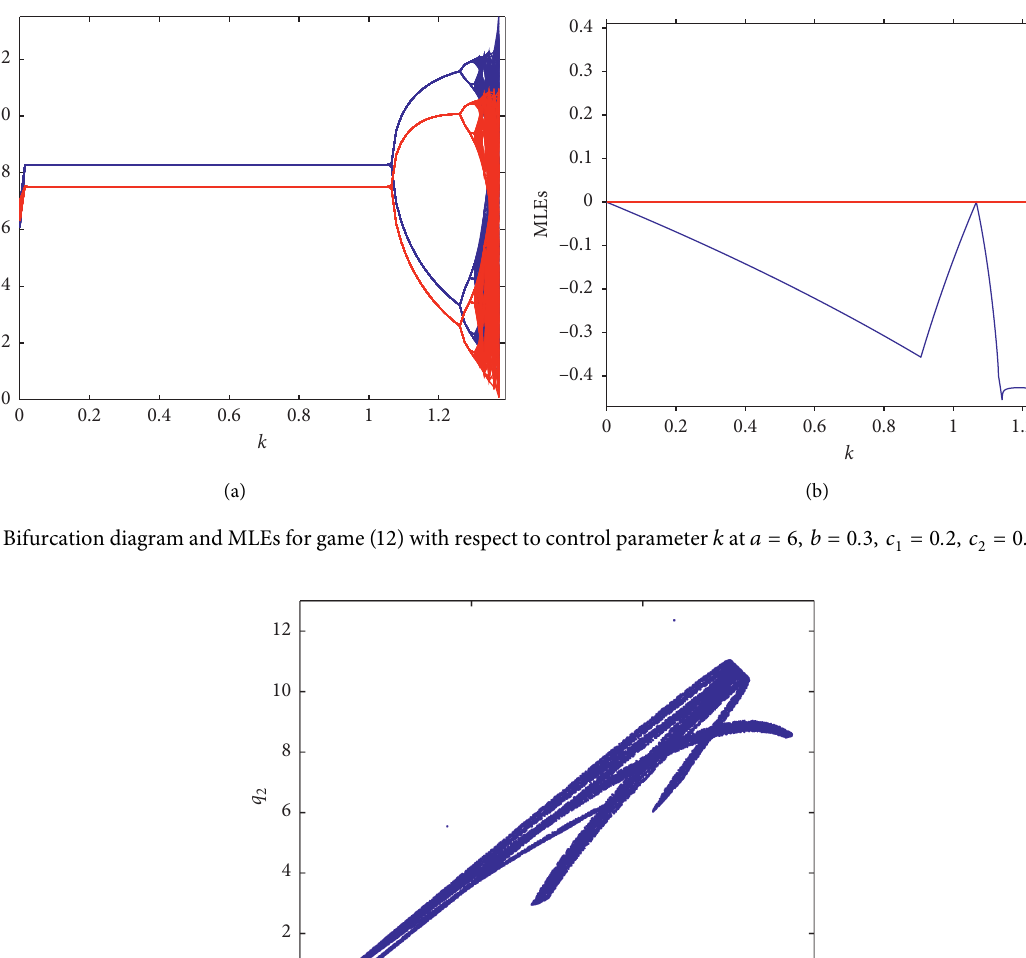
� 0 . 2 , c � 0 . 3, β � 0 . 6, 1 2